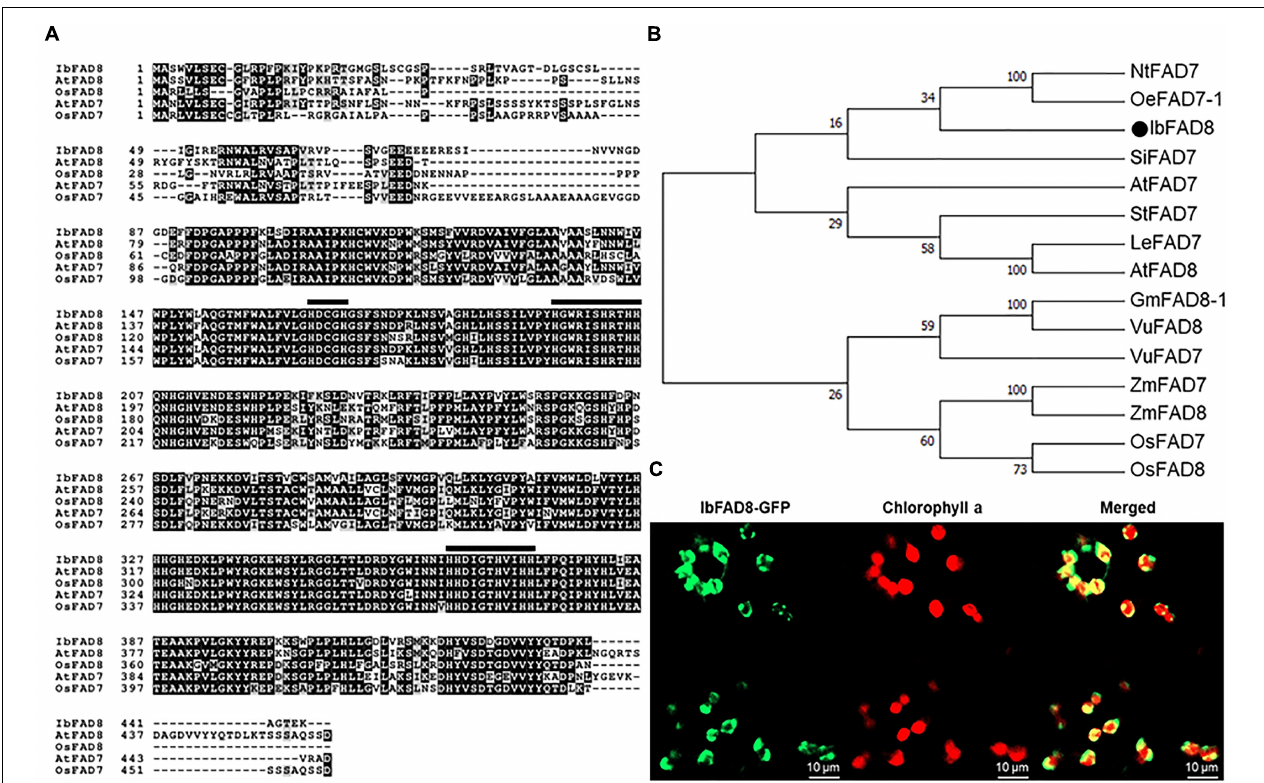
FIGURE 1 | Amino acid sequence analysis of IbFAD8. (A) Alignment of the predicted amino acid sequences of FAD8 and FAD7 of various plant species. Ib, Ipomoea batatas ; At, Arabidopsis thaliana , Os, Oryza sativa . (B) Phylogenetic analysis of the deduced amino acid sequences of plastidial FAD enzymes (FAD7 and FAD8) of various plant species. GenBank accession numbers of FAD sequences are as follows: NtFAD7 (BAC01274.1), OeFAD7-1 (AFX68461.1), SiFAD7 (NP_001306619.1), AtFAD7 (NP_187727.1), AtFAD8 (NP_196177.1), StFAD (NP_001274883.1), LeFAD7 (NP_001234592.1), GmFAD8-1 (NP_001238609.1), VuFAD8 (ABY60737.1), VuFAD7 (ABY60738.1), ZmFAD (BAA22441.1), ZmFAD8 (NP_001266540.1), OsFAD7 (BAE79783.1), OsFAD8 (AAW32557.1). (C) Subcellular localization of IbFAD8. The IbFAD8-GFP fusion was transiently expressed in Nicotiana benthamiana leaves. Confocal microscopy was used to visualize the GFP signal (green) and chlorophyll a autofluorescence (red). Merged images were used to confirm the subcellular localization of